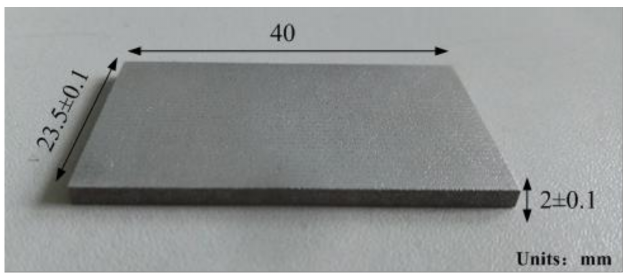
Figure 2. Dynamic shearing specimens.